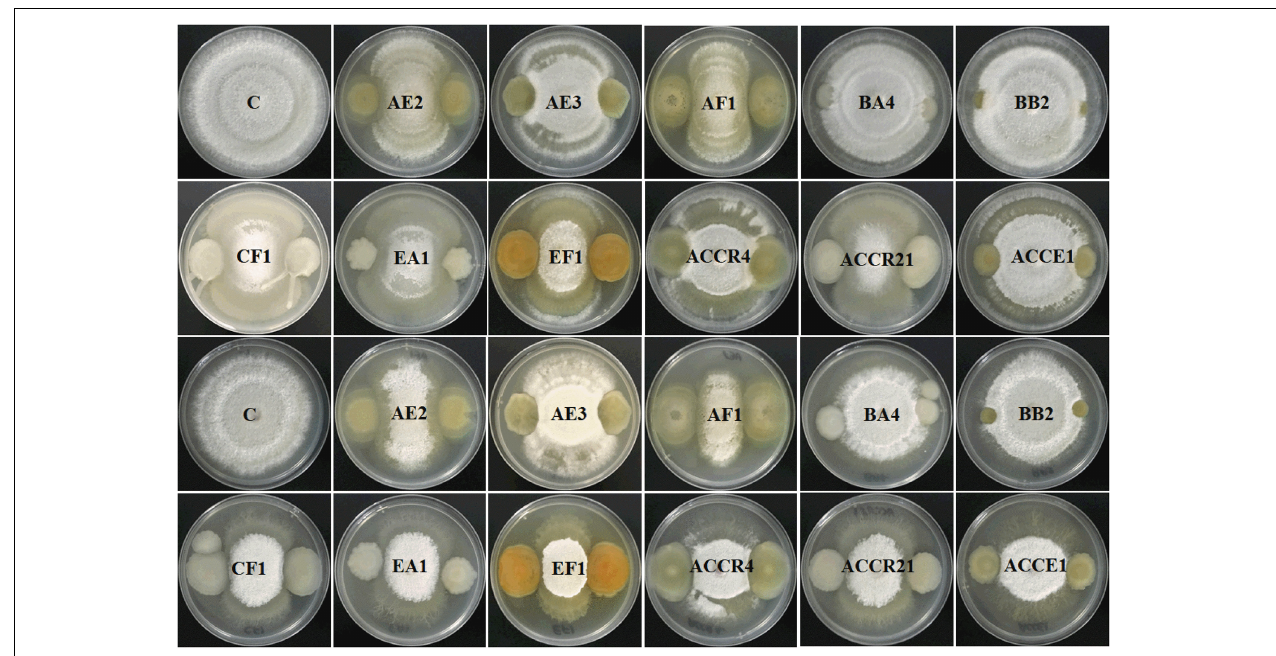
FIGURE 3 | The activity of all selected Gram-negative endophytic antagonistic bacteria against Fusarium verticillioides and Fusarium oxysporum f. sp. cubense pathogens in dual culture and inhibition percentage by culture filtrate method.